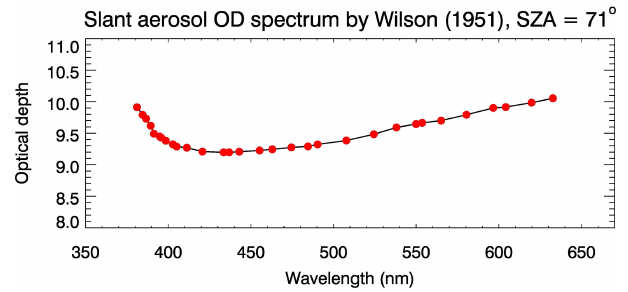
Figure 7. Spectrum of slant aerosol optical depth based on the anal- ysis by Wilson